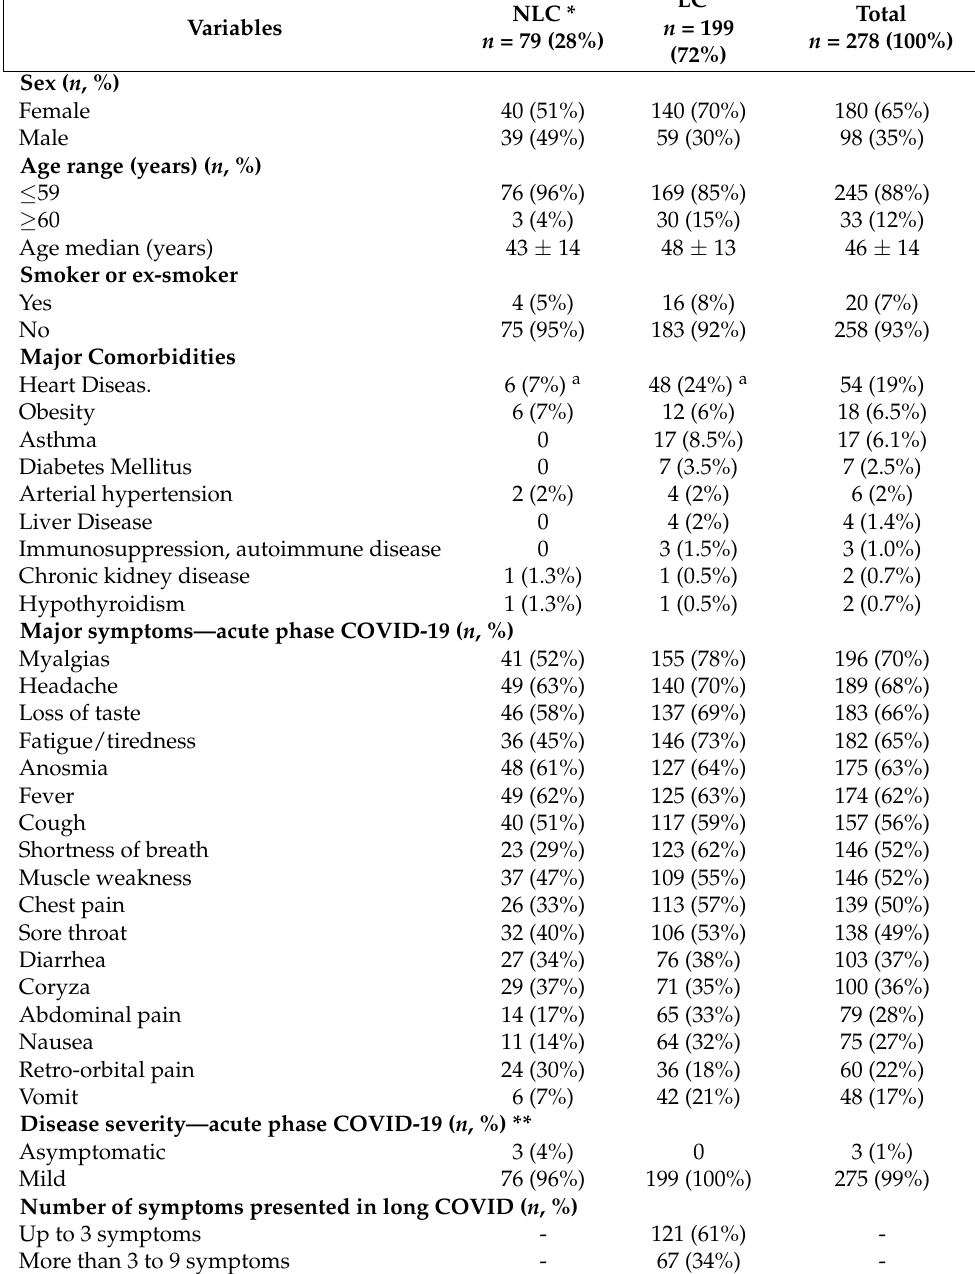
Table 1. Demographic and clinical characteristics of long COVID and non-long COVID